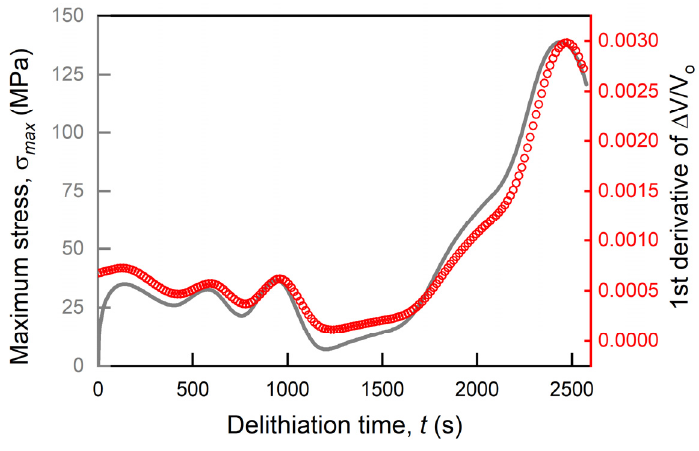
Figure 7. The delithiation time evolution of the maximum stress ( σ max ) and the 1st derivative of the volume change ( ∆ V/V o ).